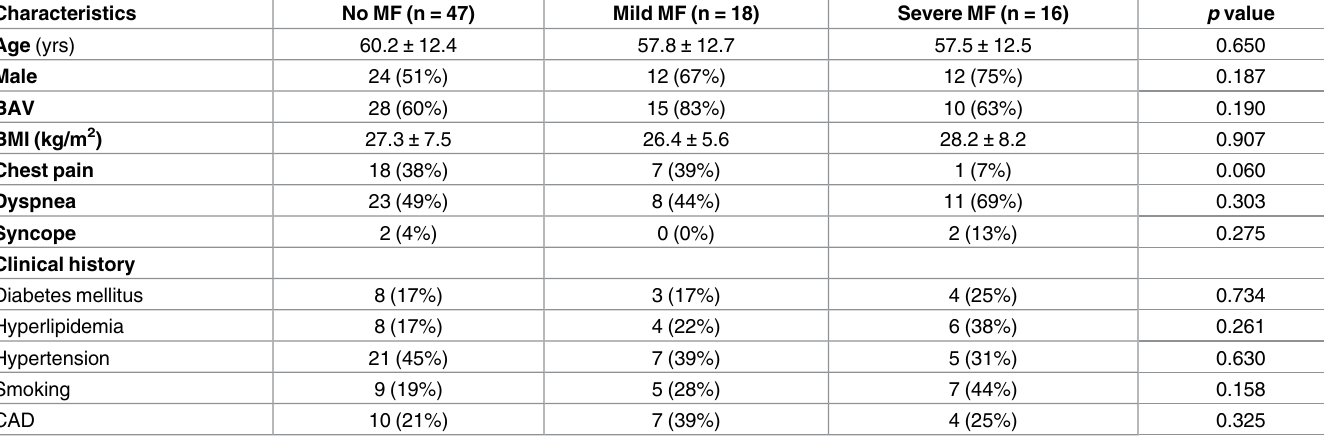
Table 1. Clinical characteristics of patients with severeaortic valve stenosis (n = 81) according to the severity of myocardial fibrosis. Characteristics